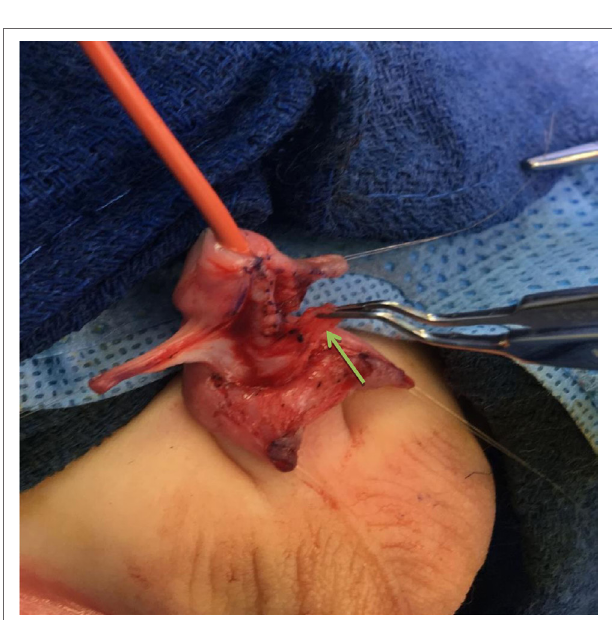
FigUre 1 | Preoperative outlining of the incision. Note that the glans is splayed and the urethral groove is deep. The infracoronal flap has been measured to match up the length of the urethral plate.